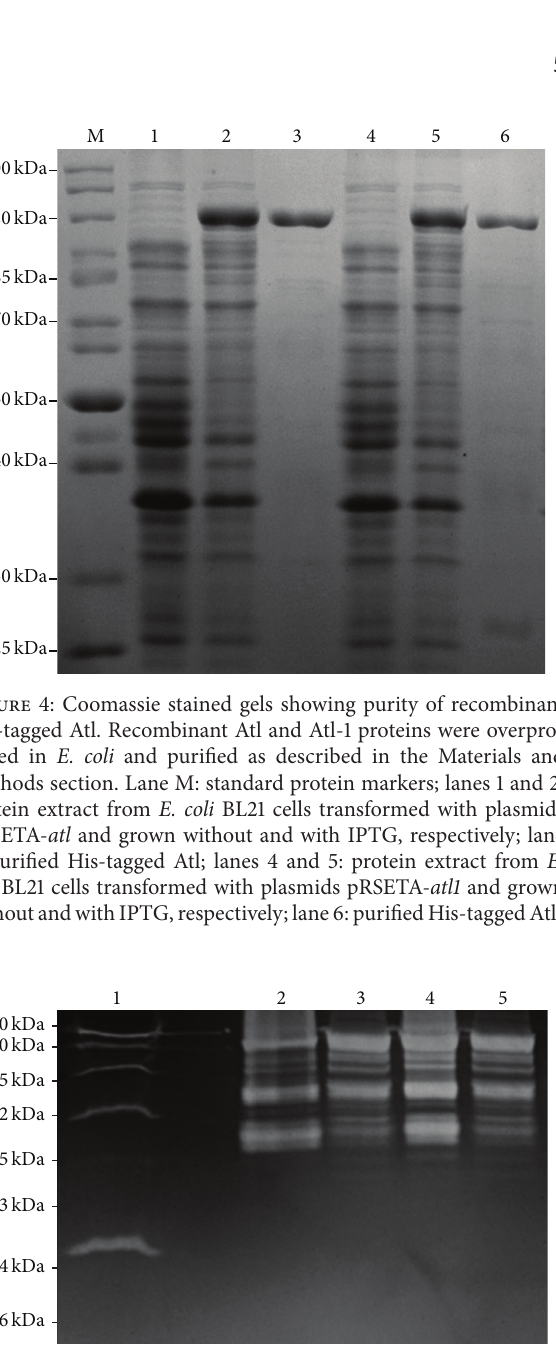
Figure 5: Zymographic detection of the autolytic activity in purified recombinant His-tagged Atl. Lane 1: total protein extract from S. aureus cells. Lanes 2 and 4: purified His-tagged Atl and Atl-1, respectively; lanes 3 and 5: protein extract from E. coli BL21 cells transformed with plasmids pRSETA- atl or pRSETA- atl1 and grown with IPTG,